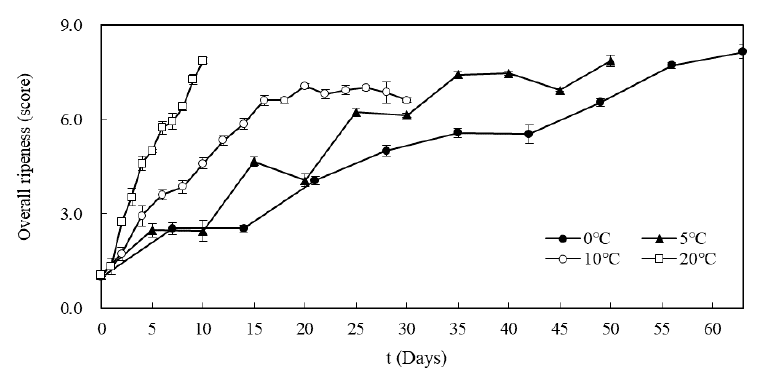
Figure 4. Comparison of the overall ripeness of Kimchi change over time at 0, 5, 10, and 20 °C. Table 1. Changes in sensory evaluation of Kimchi during fermentation at 0, 5, 10 and 20 °C.